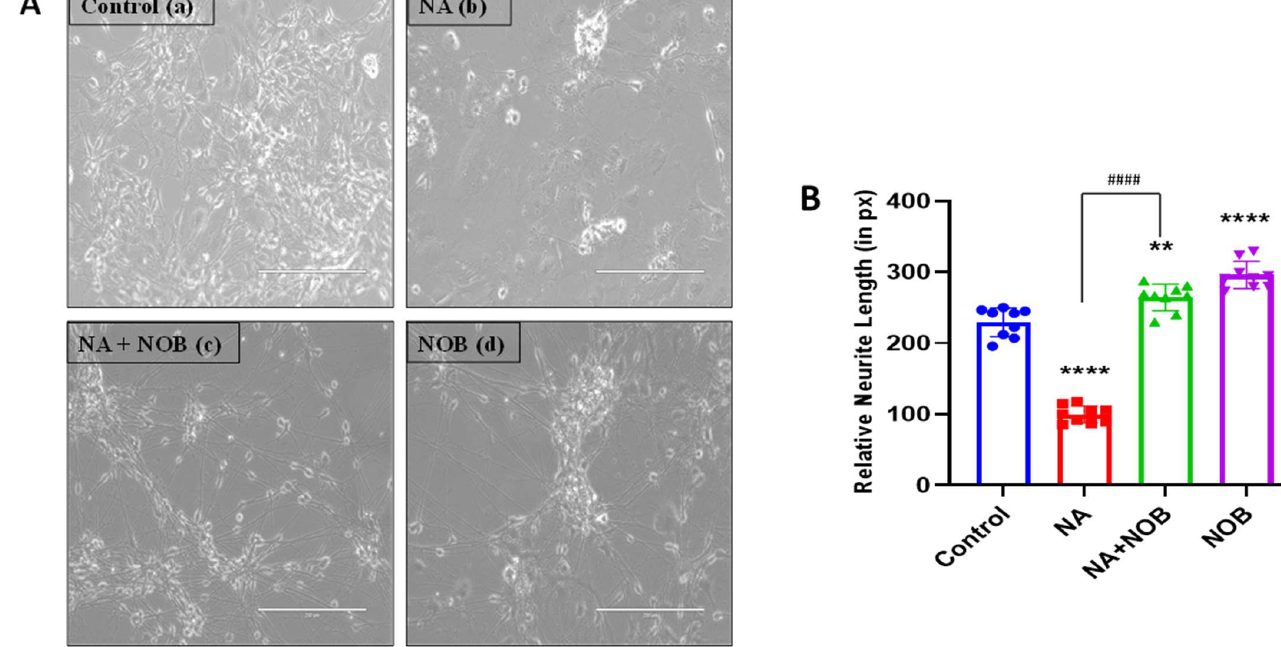
Figure 2. Neuronal protection in hNPCs: ( A ). ( a ) Morphological control, ( b ) Morphological alterations following the exposure to sodium arsenate (NA), ( c ) Morphological alterations/recovery/protection following the co-exposure to NA + NOB, and ( d ) morphological alterations following the exposure to NOB. All images are of phase contrast microscopy, which represents the biological triplicates. ( B ). Graphical representation of neurite length analysis following the different groups of exposures. Data are presented as the ± SEM, n = 3 (biological replicates including their technical replicates); the significant changes in comparison to the unexposed control group are: ** p < 0.01, **** p < 0.0001, and #### p < 0.0001 compared with NA-exposed cells. Scale bar, 200 µ M. The images were taken at a magnification of 200 ×